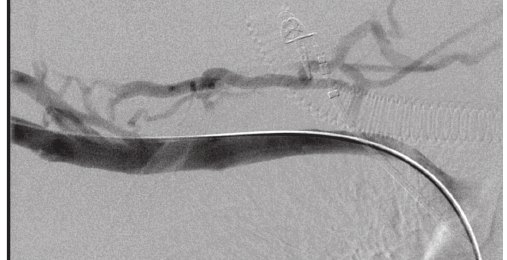
Figure 3: Digitial subtraction venogram following PMT, showing complete recanalisation of the occluded subclavian